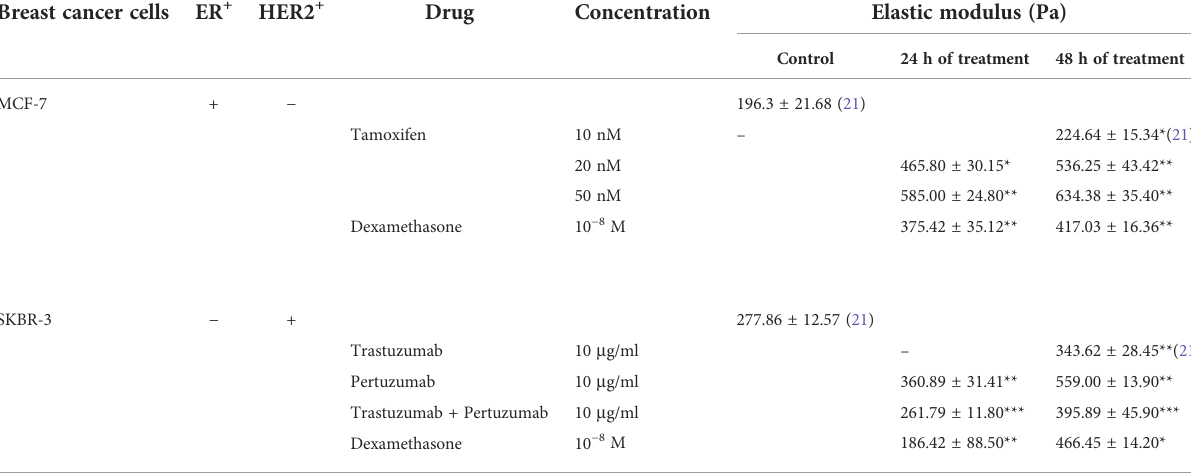
TABLE 1 Elastic Young ’ s modulus of ER + cancer cells in different tamoxifen concentrations and HER2 + cancer cells post-treatment with trastuzumab, pertuzumab, and their synergistic effect in even concentrations. Breast cancer